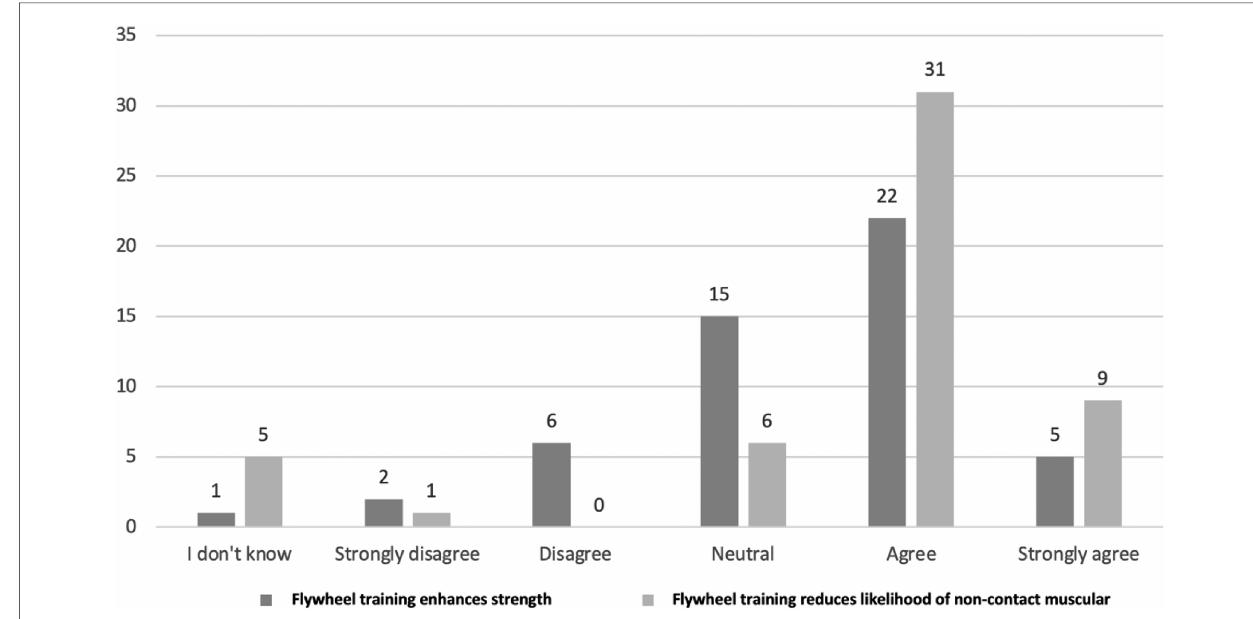
FIGURE 2 Comparing therapists opinions on the ef fi cacy of fl ywheel training for reducing likelihood of non-contact muscular injury and enhancing strength. N =52 for each statement.